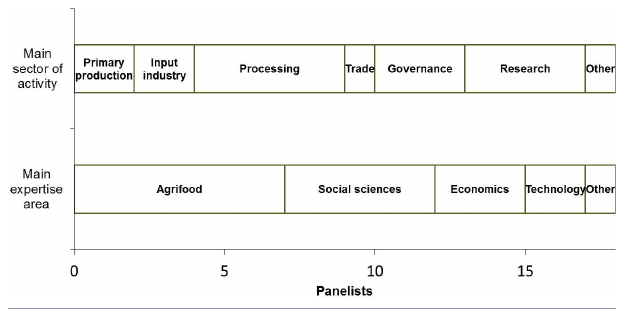
Fig. 2 . Main sectors of activity and expertise areas of the Delphi panelists (n =